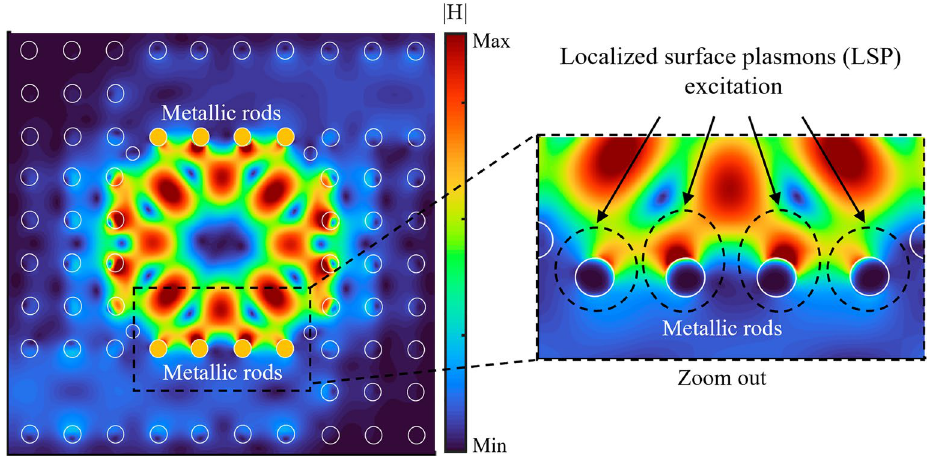
Figure 3. The magnetic field distribution (|H|) for the proposed hybrid P-PhC sensor at the resonance wavelength of 1860 nm.